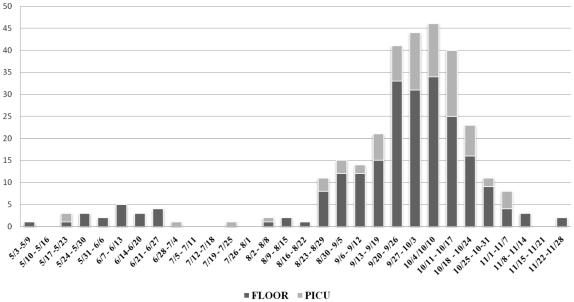
Children hospitalized with 2009 H1N1 influenza infection by week of admission.